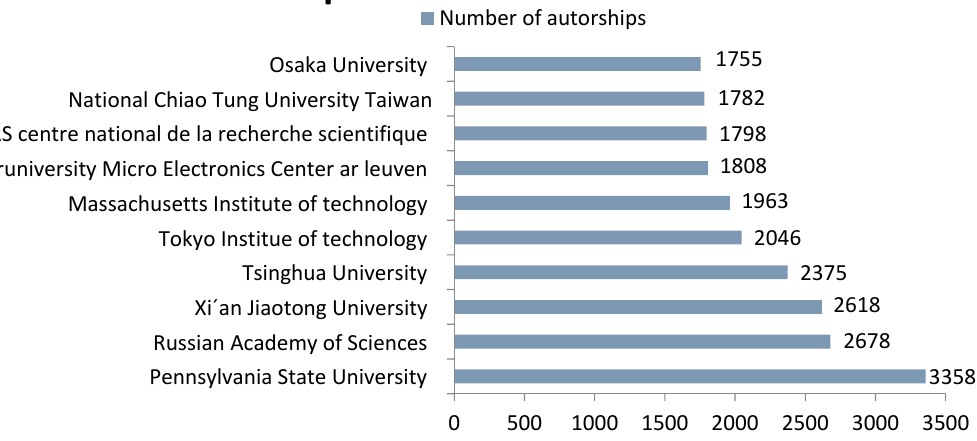
Figure 5. Ranking of the top 10 institutions publishing on dielectric.